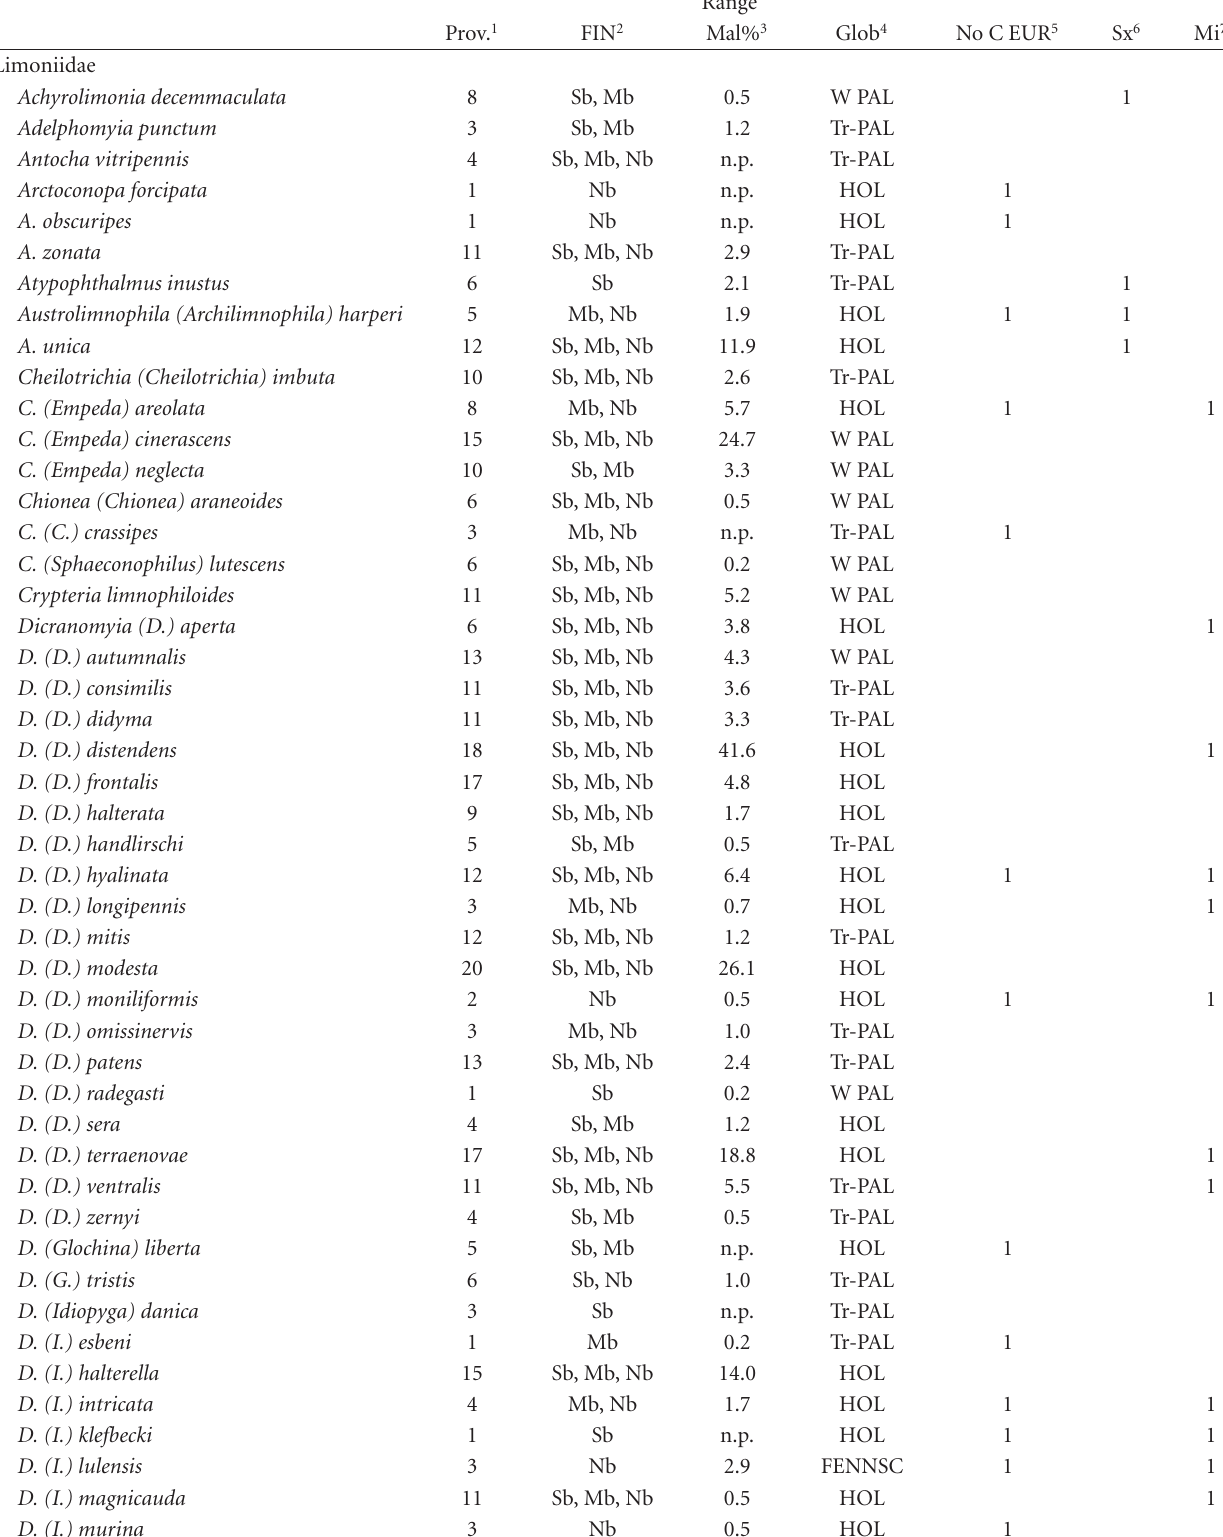
Table 6: List of Finnish crane fly (Diptera, Tipuloidea) species, supplied with information on regional and global range size. Saproxylic/fungivorous and mire-dwelling species are indicated. Nomenclature follows Oosterbroek